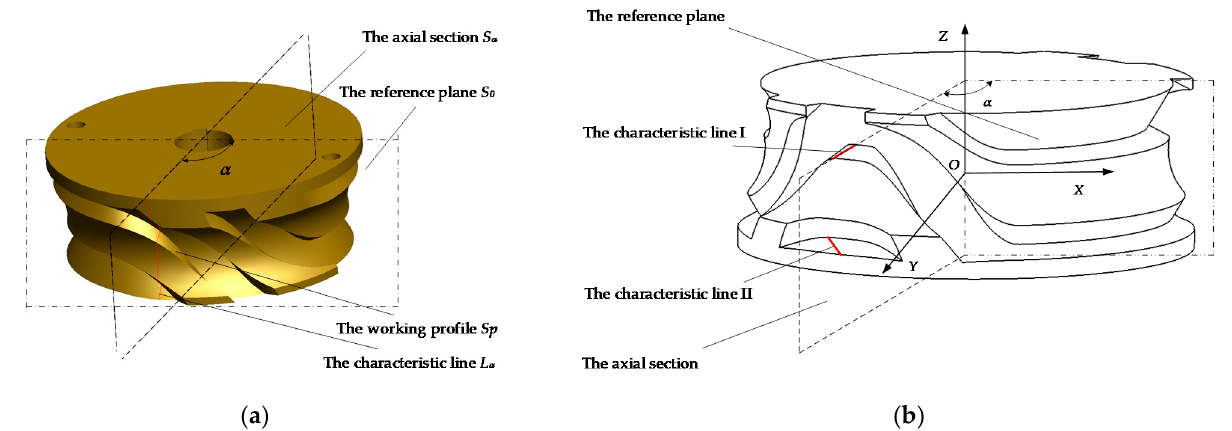
Figure 5. Globoidal cam characteristic line and coordinate system. ( a ) Globoidal cam profile and characteristic line; ( b ) Coordinate system of globoidal cam characteristic line.